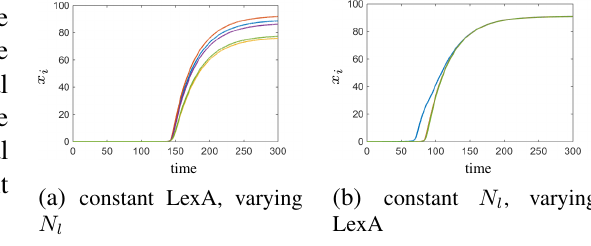
Fig. 9: Time course of the intracellular AHL- concentration of ten cells within one colony influenced by LexA and Regulator n l